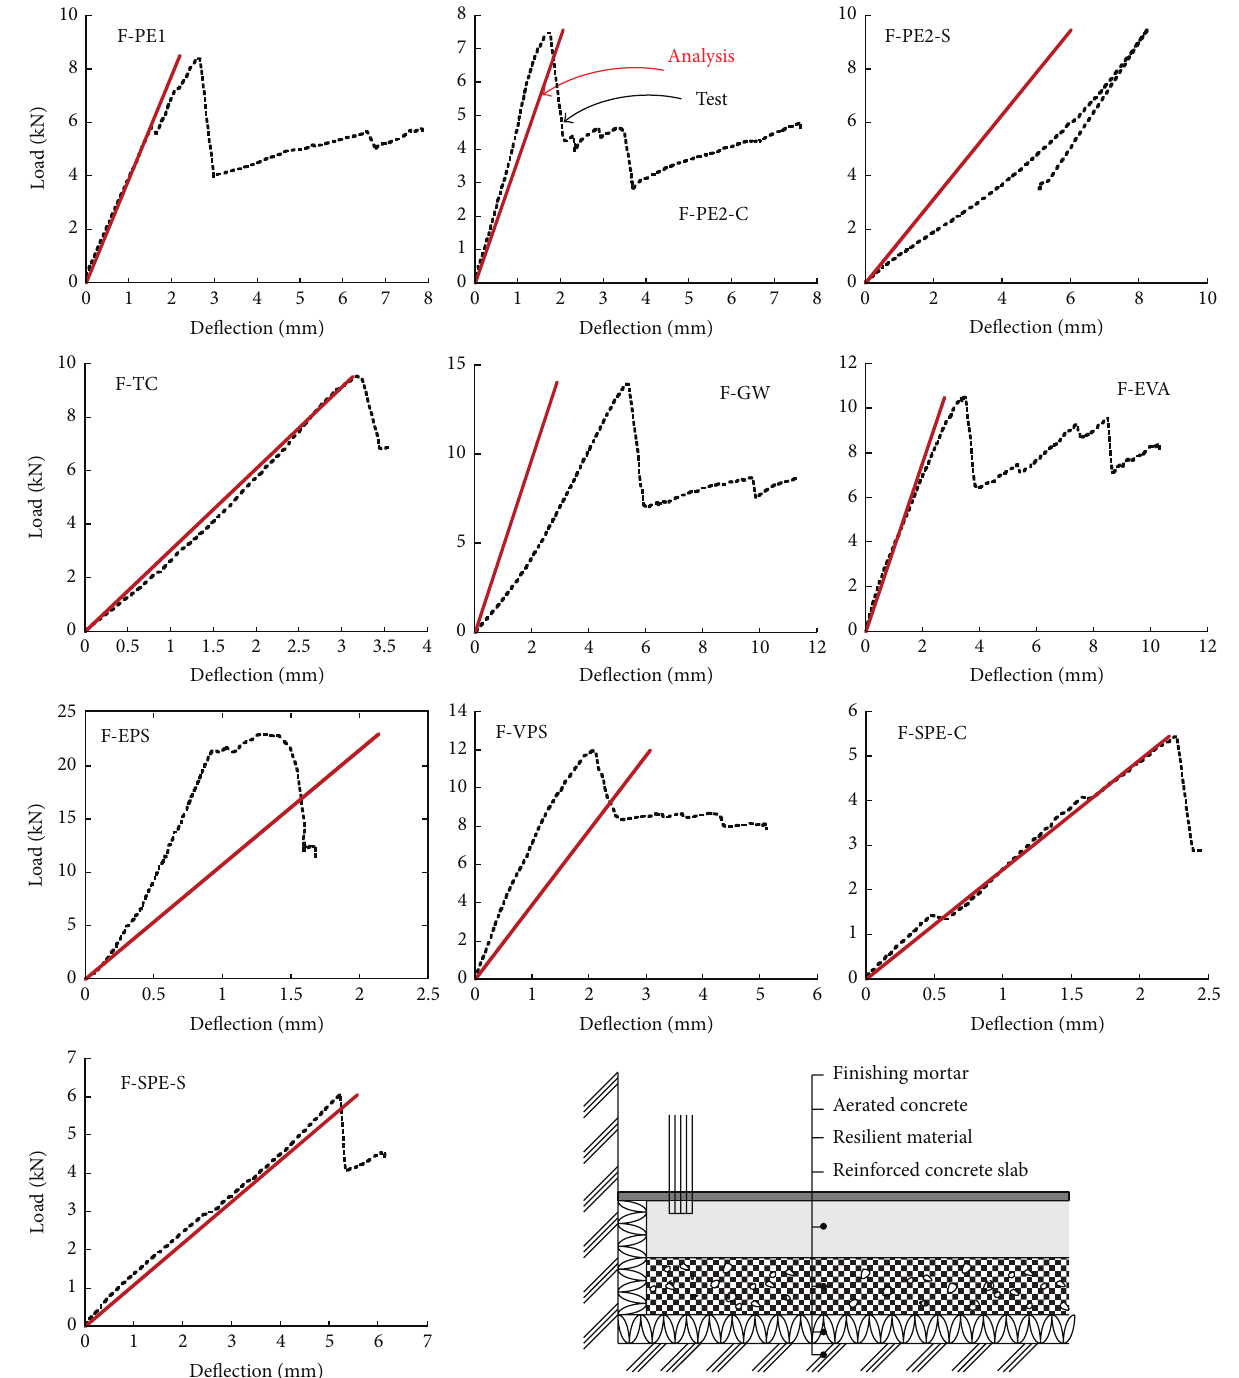
Figure 7: Comparisons of the observed and predicted load versus deflection curves.